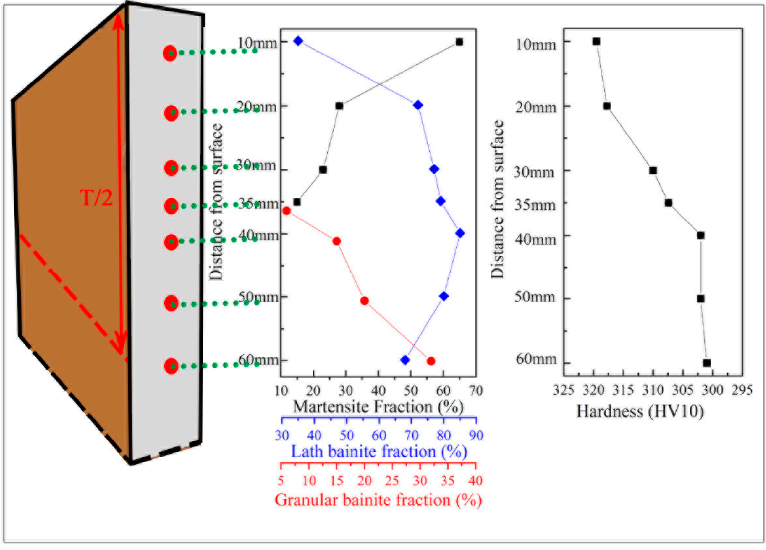
Figure 8. Microstructural evolution through the thickness of the heavy plate.